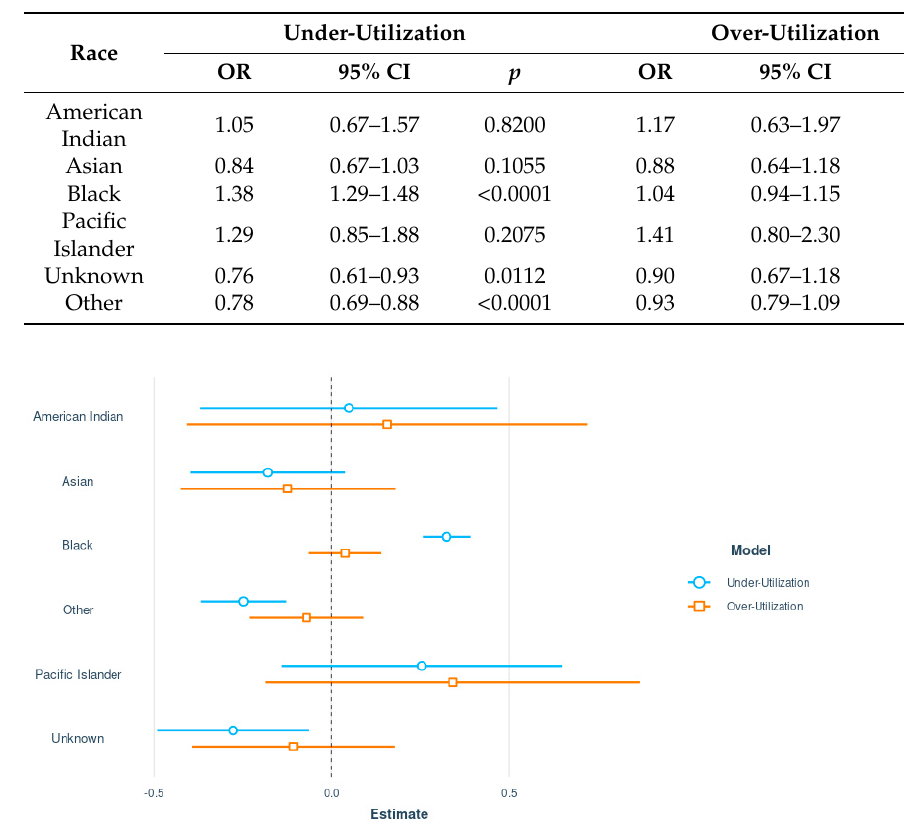
Figure 3. Forest plot showing the logistic regression coefficient estimates representing the associations between race and under- and over-utilization, with White patients representing the reference category.